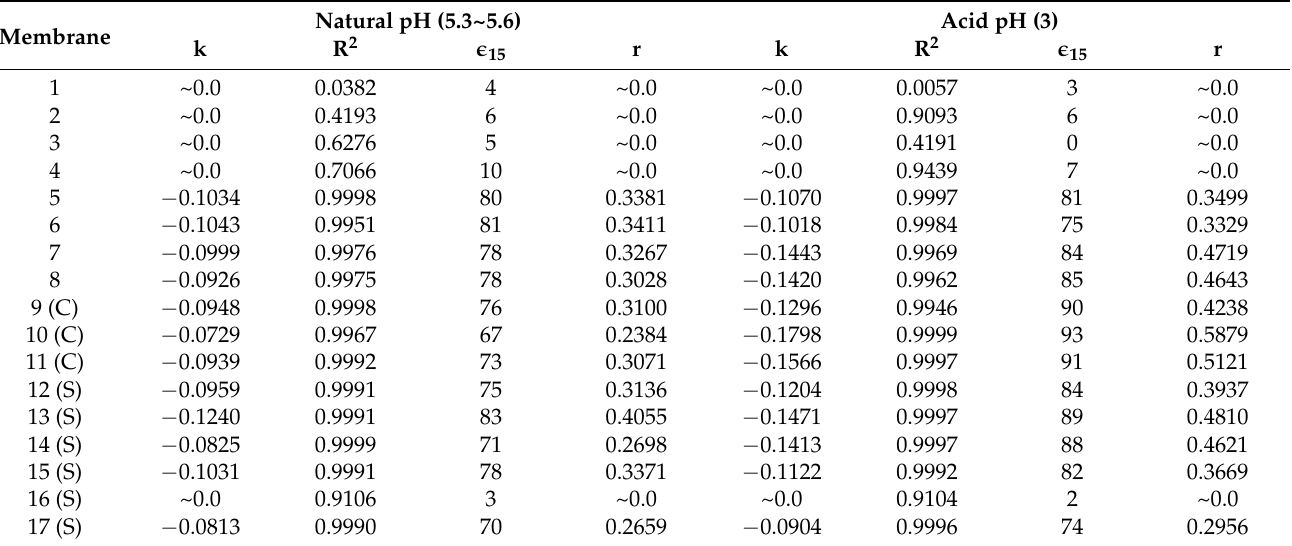
Table 8. Decolorization of methyl orange (C 0 = 10 − 5 M~3.27 mg L − 1 ) at different pH ranges ac- cording to the central composite design and characterization results of the modified membranes (17 experiments: 2 3 = eight experiments + three (C) center points + six (S) star-points). Apparent rate constants k (h − 1 ) were calculated from the slope of ln(Abs/Abs 0 ) versus time, R 2 is the correlation coefficient of the generated curve, (cid:15) 15 is the decolorization efficiency after 15 h of experiment (%), and r is the initial reaction rate (mg L − 1 h − 1 ).